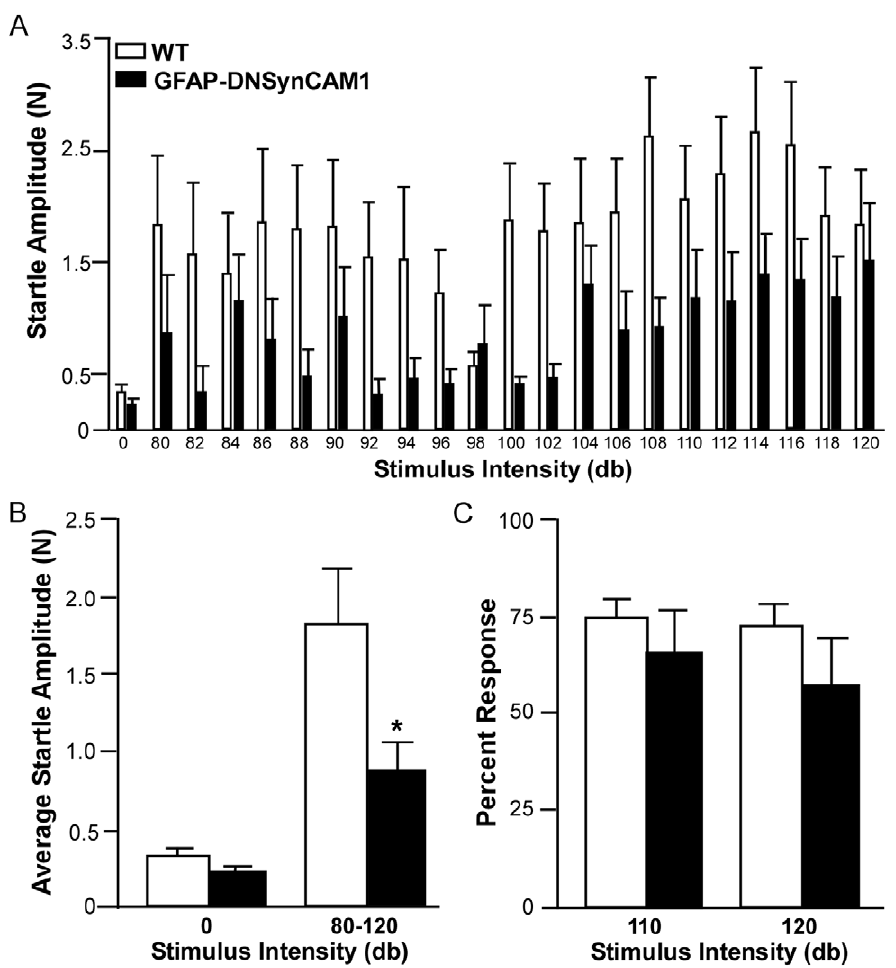
Figure 5. GFAP-DNSynCAM1 mice have reduced anxiety in the acoustic startle paradigm. ( A ) Startle amplitudes for the GFAP- DNSynCAM1 (black bars; n=8) and WT (white bars; n=7) mice for each of the sound intensities tested. Data points represent means 6 SEM. Data were analyzed with ANOVA for repeated measures. ( B ) The average startle amplitudes for each genotype during baseline (0 db) and after different stimulation intensities (80–120 db). ( C ) Percent response of GFAP-DNSynCAM1 (black bars; n=9) and WT (white bars; n=8) in the PPI test using two different stimuli intensities (110 and 120 db). The data are represented as the mean 6 SEM and analyzed by two- way ANOVA (intensity by genotype) followed by unpaired t test post hoc analysis. * p , 0.05.